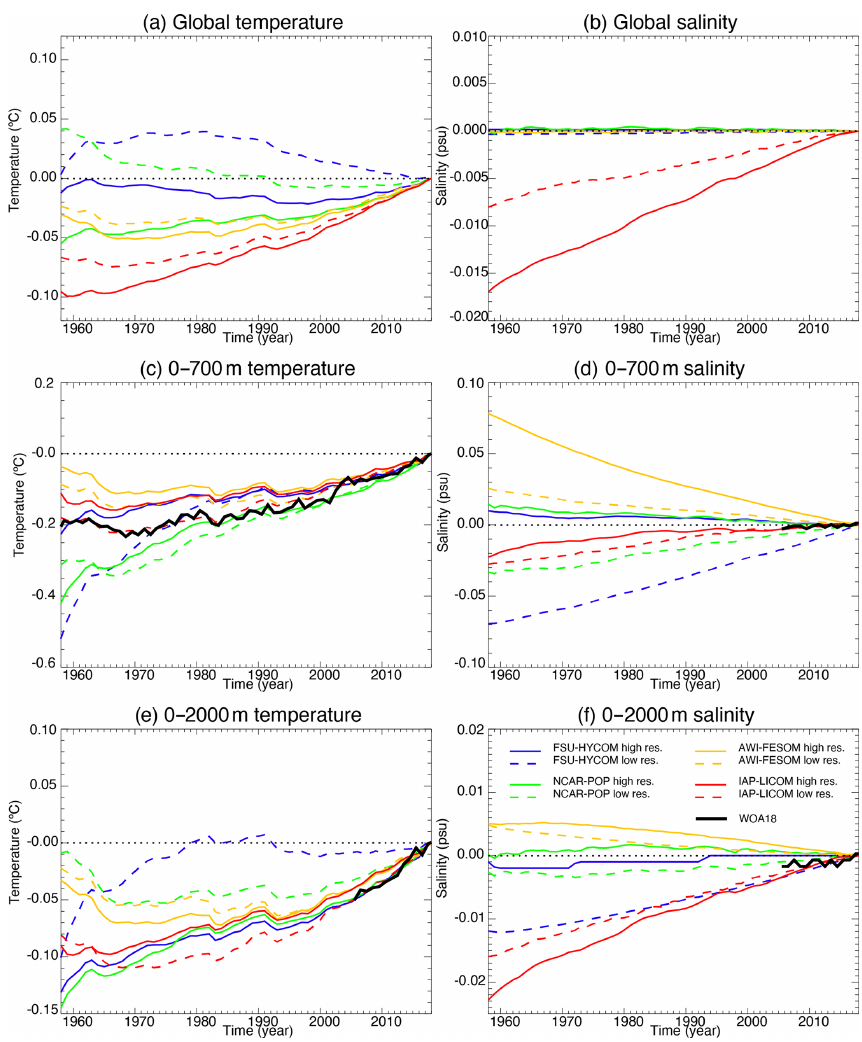
Figure 5. Time evolution of global temperature ( ◦ C) and salinity (psu) change (relative to the year 2018) for all experiments and the World Ocean Atlas (WOA18) (depth-integrated, upper 700m, upper